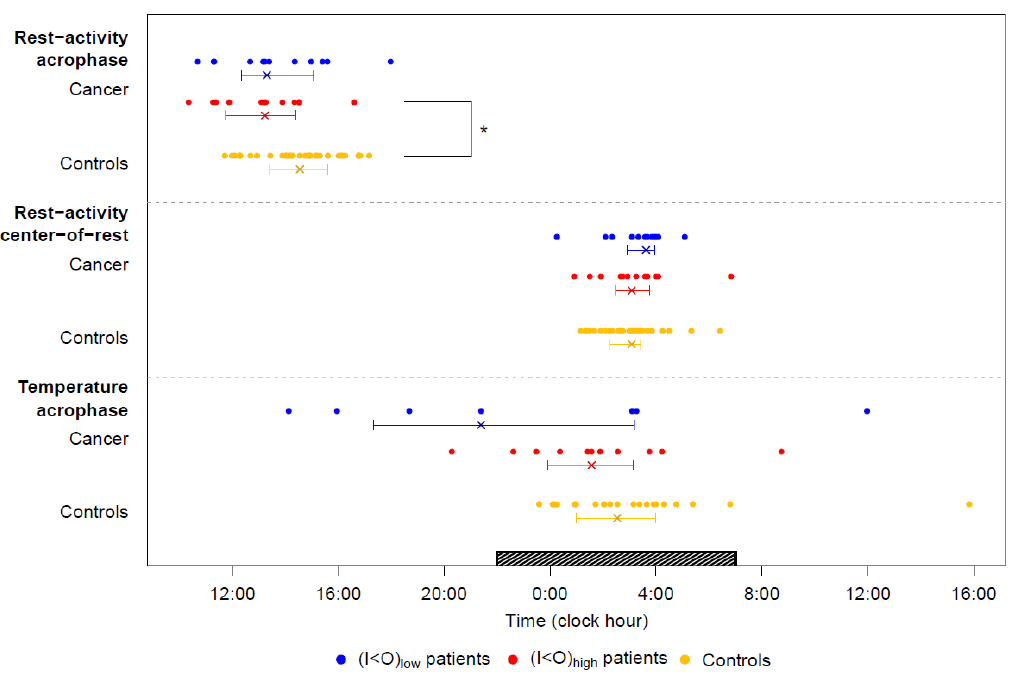
Figure 4. Daily timing of the tele-monitored circadian biomarkers. Median, interquartiles, and individual timings of each circadian biomarker in (I < O) low and (I < O) high patients and in controls. Median values are marked by a cross; horizontal bars represent interquartile range. Timings for each individual are plotted as dots (for rest-activity, 12 patients for each I < O group, and 33 controls; for temperature, 7 and 11 patients in the (I < O) low and (I < O) high groups, respectively, and 21 controls). The dark bar on the abscissa represents the night span (22:01 to 7:00). Chest surface temperature acrophase are shown for the participants displaying a significant circadian rhythm. Levels of significance: * 0.01< p ≤0.05 (two - tailed Welch’s modified t -test).